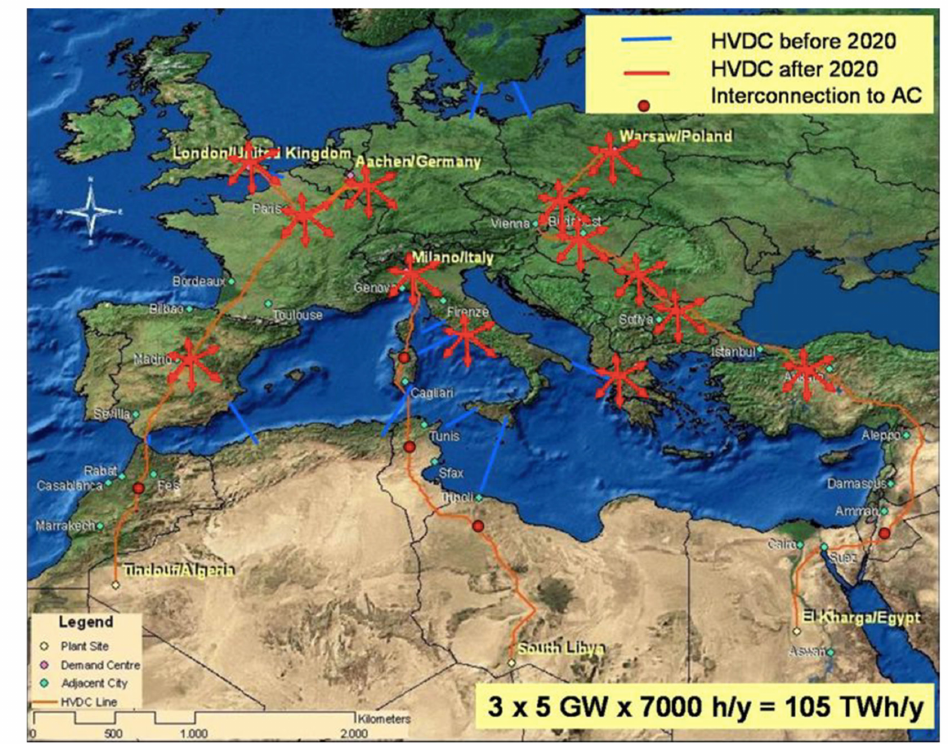
Figure 1. HVDC lines for connecting North Africa with Europe in DESERTEC and DII plans of